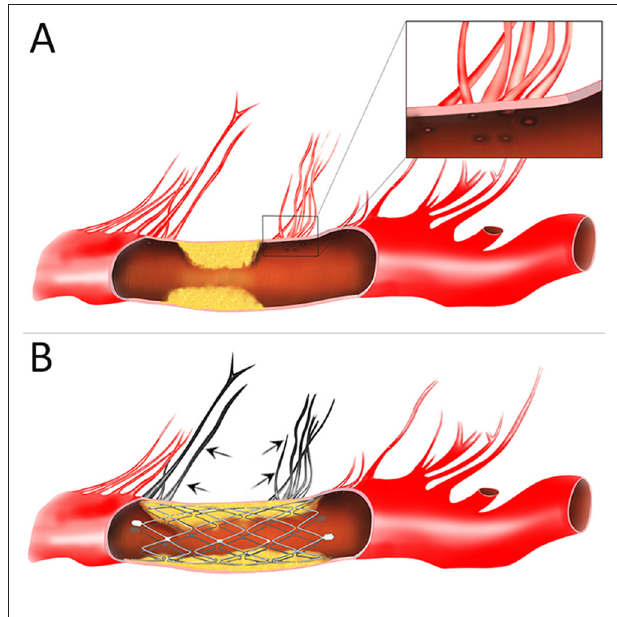
FIGURE 5 | Schematic diagram of the “snow-plowing” effect. (A) An intracranial atherosclerotic arterial stenosis with perforator vessels. Inset: the magnified view of perforator ostia. (B) After stent deployment, forceful displacement of the plaque causes occlusion of the perforator vessels (arrow).